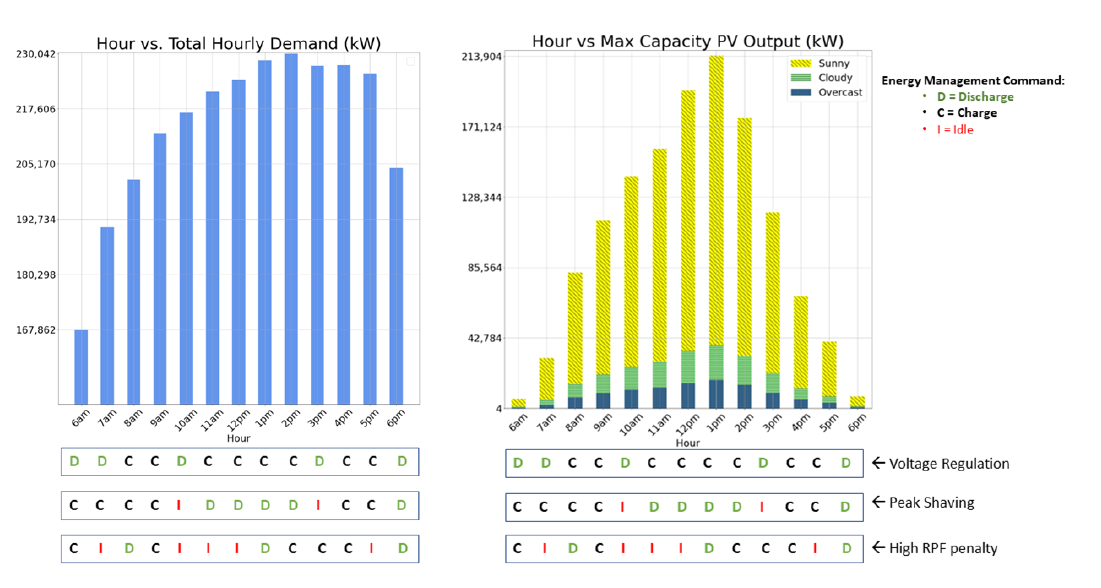
Figure 3. Example charging strategies ( bottom ) produced compared to total hourly demand ( left ) and example PV output ( right ) for the maximum capacity